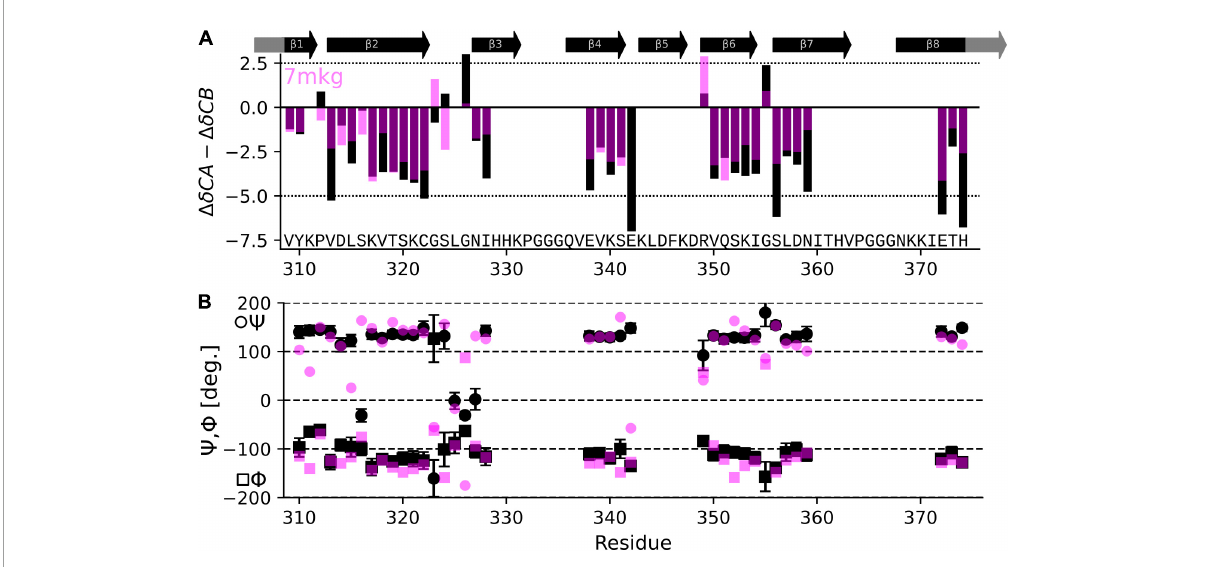
FIGURE4 Comparison of NMR assignment and existing cryo-EM structures. (A) Difference in CA and CB secondary chemical shift ( S = (cid:49) δ C α − (cid:49) δ C β ) as derived from the NMR assignment (black) and calculated from the tau PrP-CAA SF cryo-EM structure (PDB entry 7mkg, fuchsia) using the program ShiftX2. Both secondary shifts overlap well indicating a similar structure. However, there are notable exceptions, specifically P312, G324, S324, G326, and E342. (B) Psi ( (cid:57) ), phy ( (cid:56) ) dihedral angles calculated from the NMR assignment using the program TALOS-N (black) and taken from the cryo-EM structure